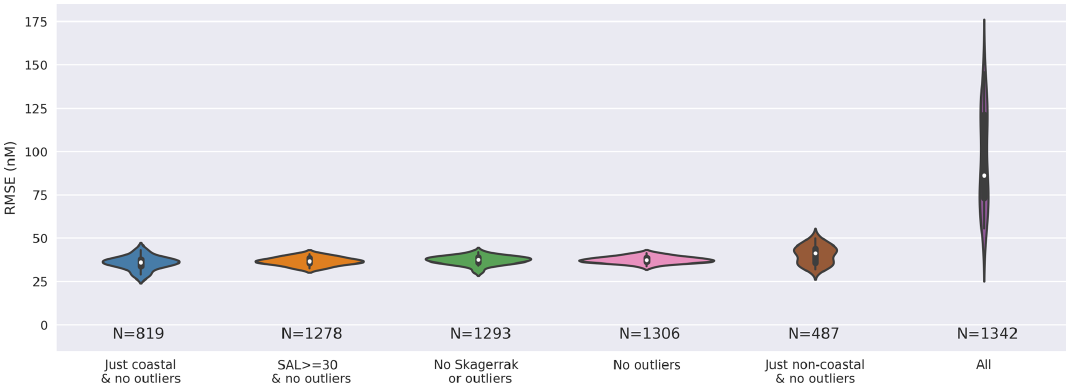
Figure A1. Combined kernel density and violin plots showing the distribution of the root mean square error (RMSE) for 20 different models built from 20 different pseudo-random initialisations for a different selection of the dataset as described in Table 2 and Sect.3.2. Models built using the whole dataset (“all”), including outliers, show a significantly higher RMSE due to observations with higher iodide concentrations. The model used here includes ancillary variables of temperature, depth, and salinity which were thought to intuitively give a reasonable result.